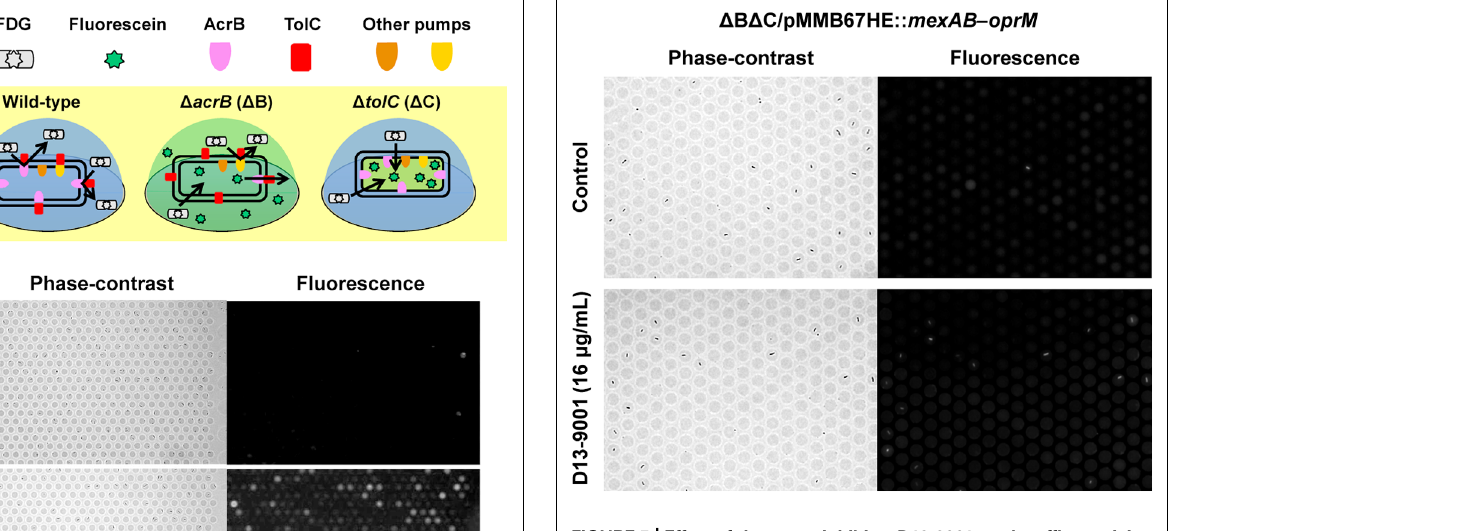
PHENOTYPIC CHANGE AFTER GENETIC TRANSFORMATION